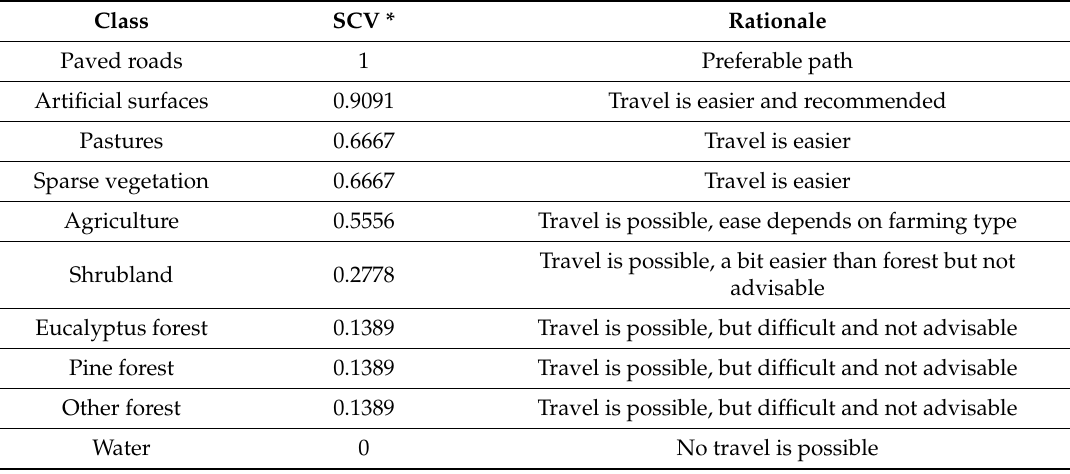
Table 2. Speed-conservation values (SCV) for the nine categories of land cover used in the Pedestrian Evacuation Analysis Tool. Values were based on the tool guidelines [60] and adjusted to the characteristics of the civil